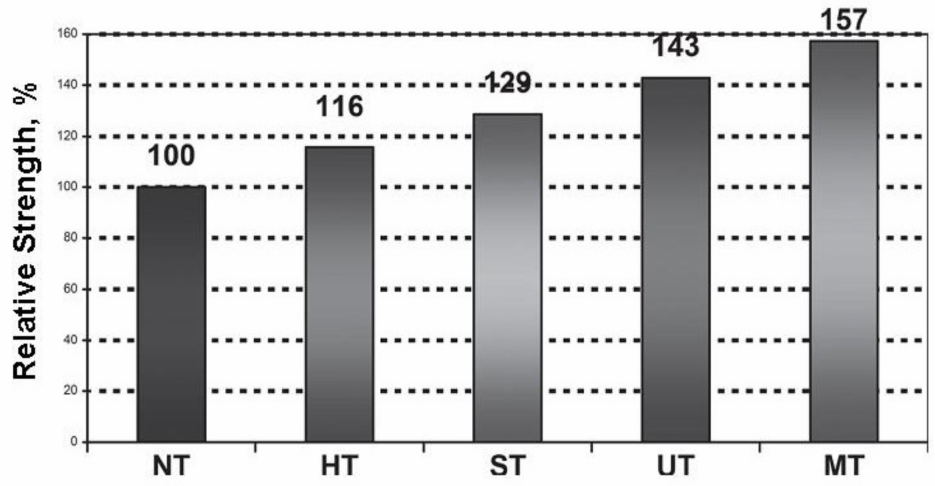
Figure 2. Change of wire strength depending on its group. Reprinted from ref.